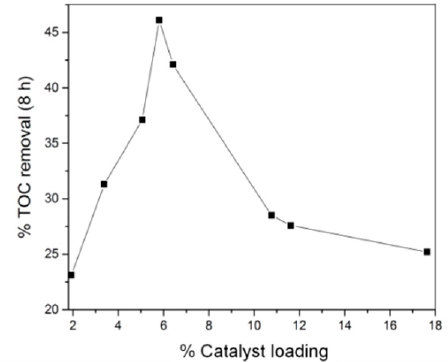
Figure 4. Percent total organic carbon (TOC) removal of 200 mL Acid Orange 7 (AO7) (0.1 mM) after 8 h treatment by heterogeneous EF process as a function of catalyst loading deposited on carbonized CF@MIL-53(Fe) cathode.